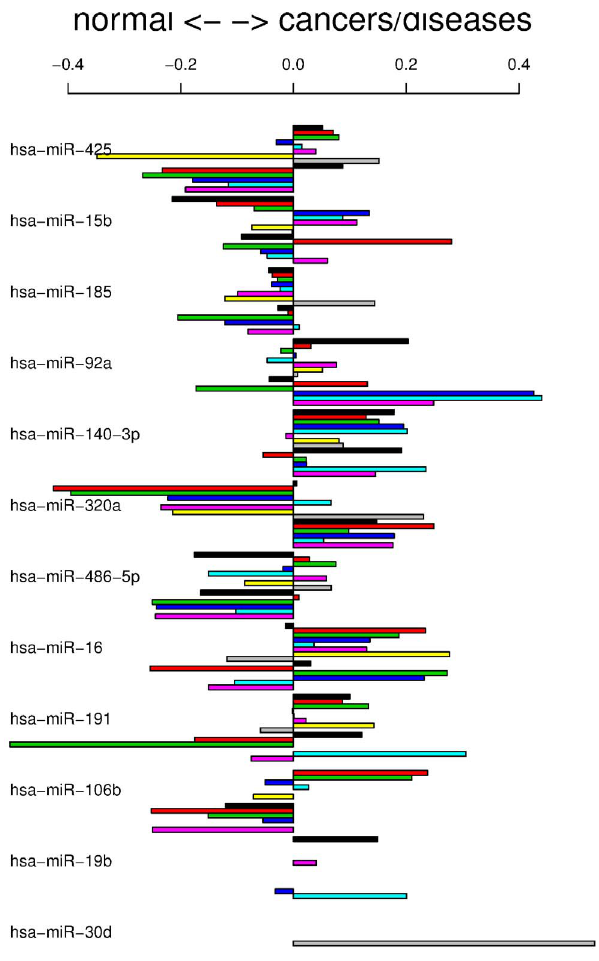
Figure 1. Individual contributions of miRNAs to discrimination between patients with cancers or other diseases and normal controls. The height of the bars indicates the amount of contribution from each miRNA in discriminating patients with cancers or other diseases from healthy controls. A positive (negative) value indicates that the miRNA was expressed in patients with cancer and other diseases (healthy controls). The order of cancers or other diseases is the same as that in Table 2 (top to bottom): lung cancer (black), other pancreatic tumors and diseases (red), pancreatitis (green), ovarian cancer (blue), COPD (cyan), ductal pancreatic cancer (pink), gastric cancer (yellow), sarcoidosis (grey), prostate cancer (black), acute myocardial infarction (red), periodontitis (green), multiple sclerosis (blue), melanoma (cyan), and Wilm’s tumor (pink).